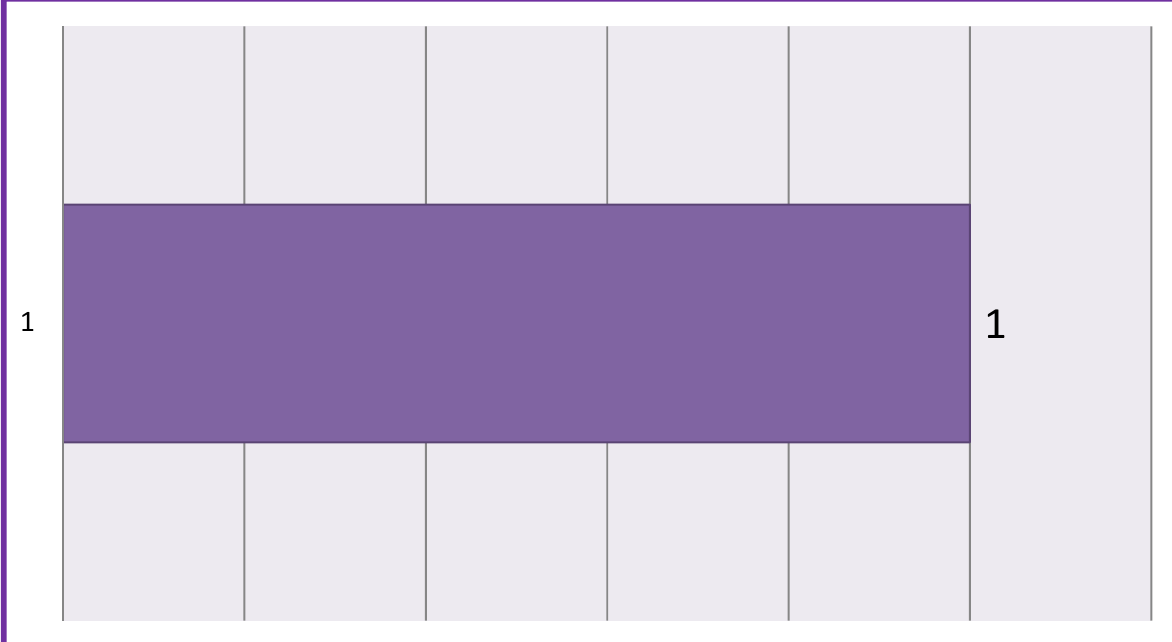
Figure 5. GARS Panel Association Studies [85].